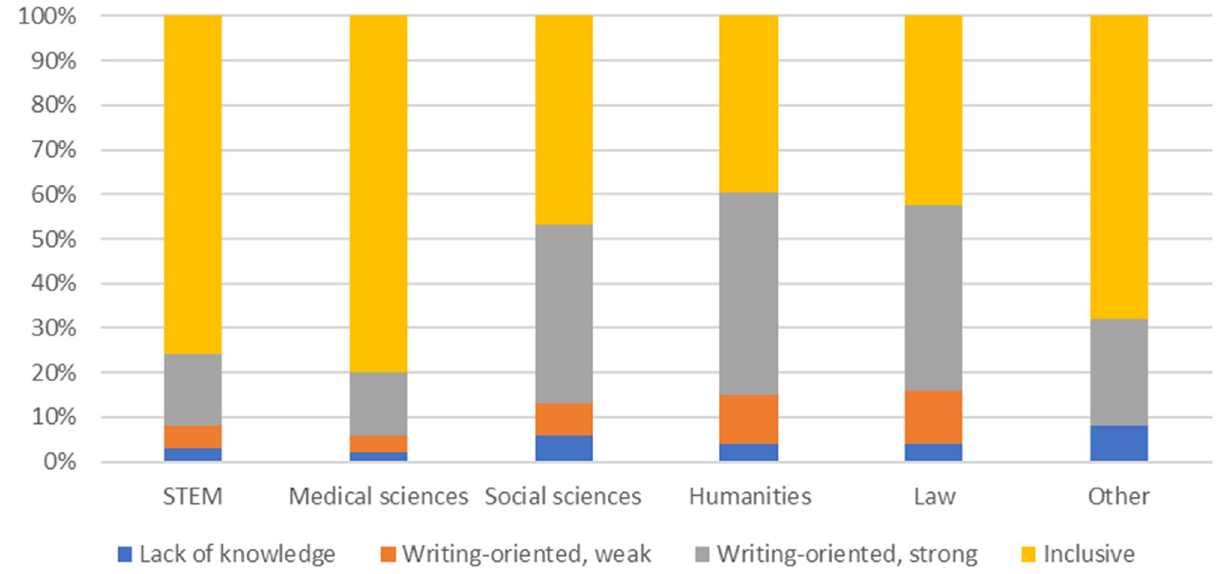
Fig 1. The distribution of the four views on authorship within the different faculties (shares are based on predicted probabilities).